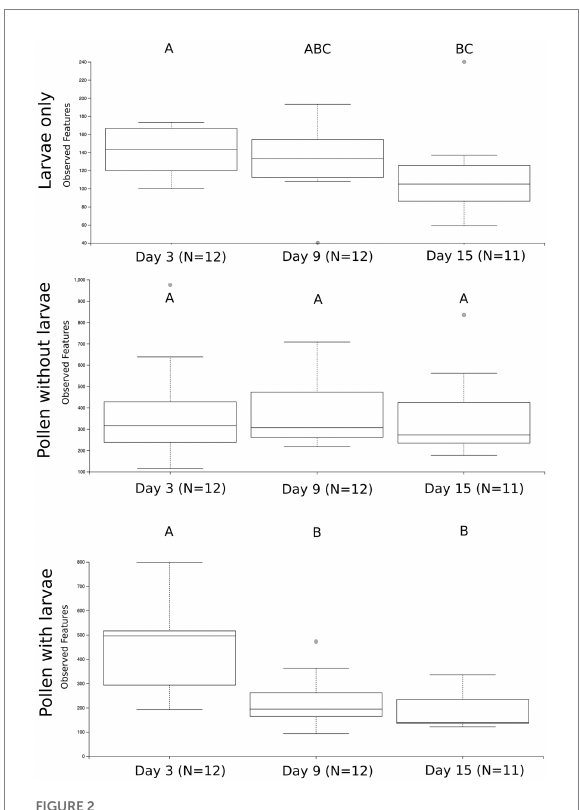
FIGURE 2 The number of unique bacterial ASVs summarized by the three treatment groups and sampling time points. Significance is denoted by (A–C) . Significant differences in bacterial richness across time points were found using a Kruskal Wallis test for larvae only (H = 4.69, p = 0.096) and pollen with larvae (H = 11.53, p = 0.003), but not for pollen without larva (H = 0.358, p =